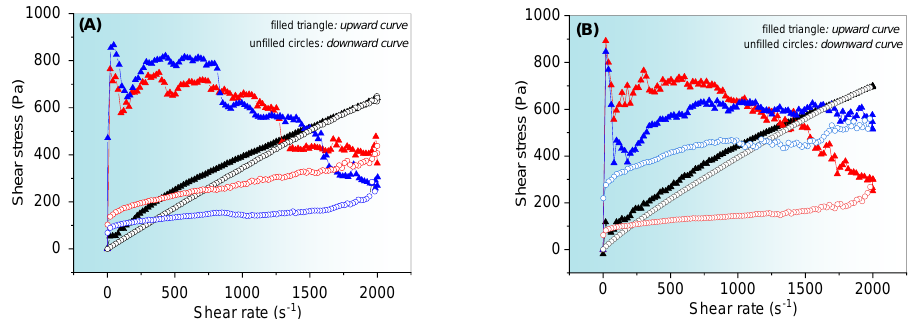
Figure 5. The flow curves of ( A ) EOCh-0.5 and ( B ) EOCh-1.0 systems at different temperatures. The symbols in blue correspond to measurements at 37.0 °C, red at 25.0 °C, and black at 5.0 °C. The filled triangles correspond to the upward curve, and the open circles (with borders of the same color) to the respective downward curve. Standard deviations were omitted for clarity; however, in all cases, the coefficient of variation of the replicate analyses was <10%.